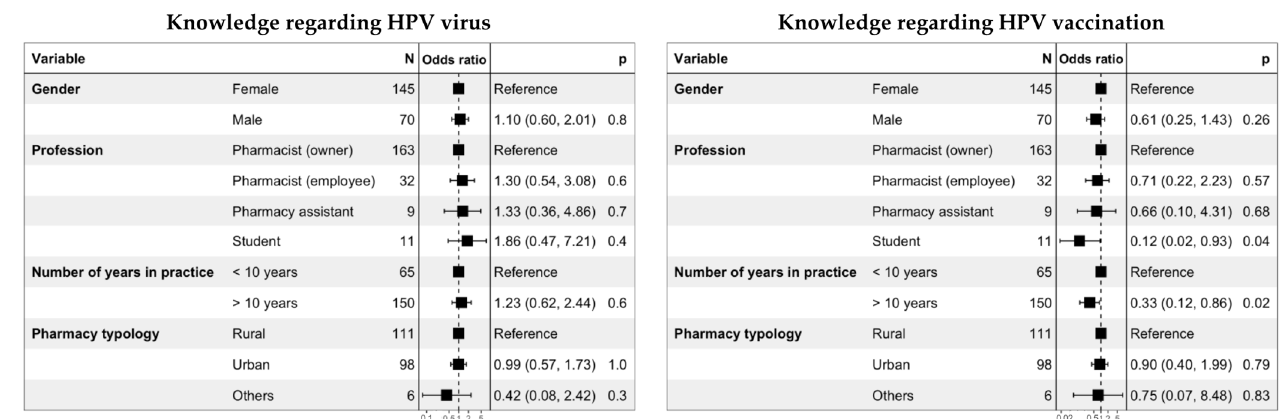
Figure 5. Ordinal logistic regressions performed to evaluate the determinants of the level of knowledge related to HPV and HPV